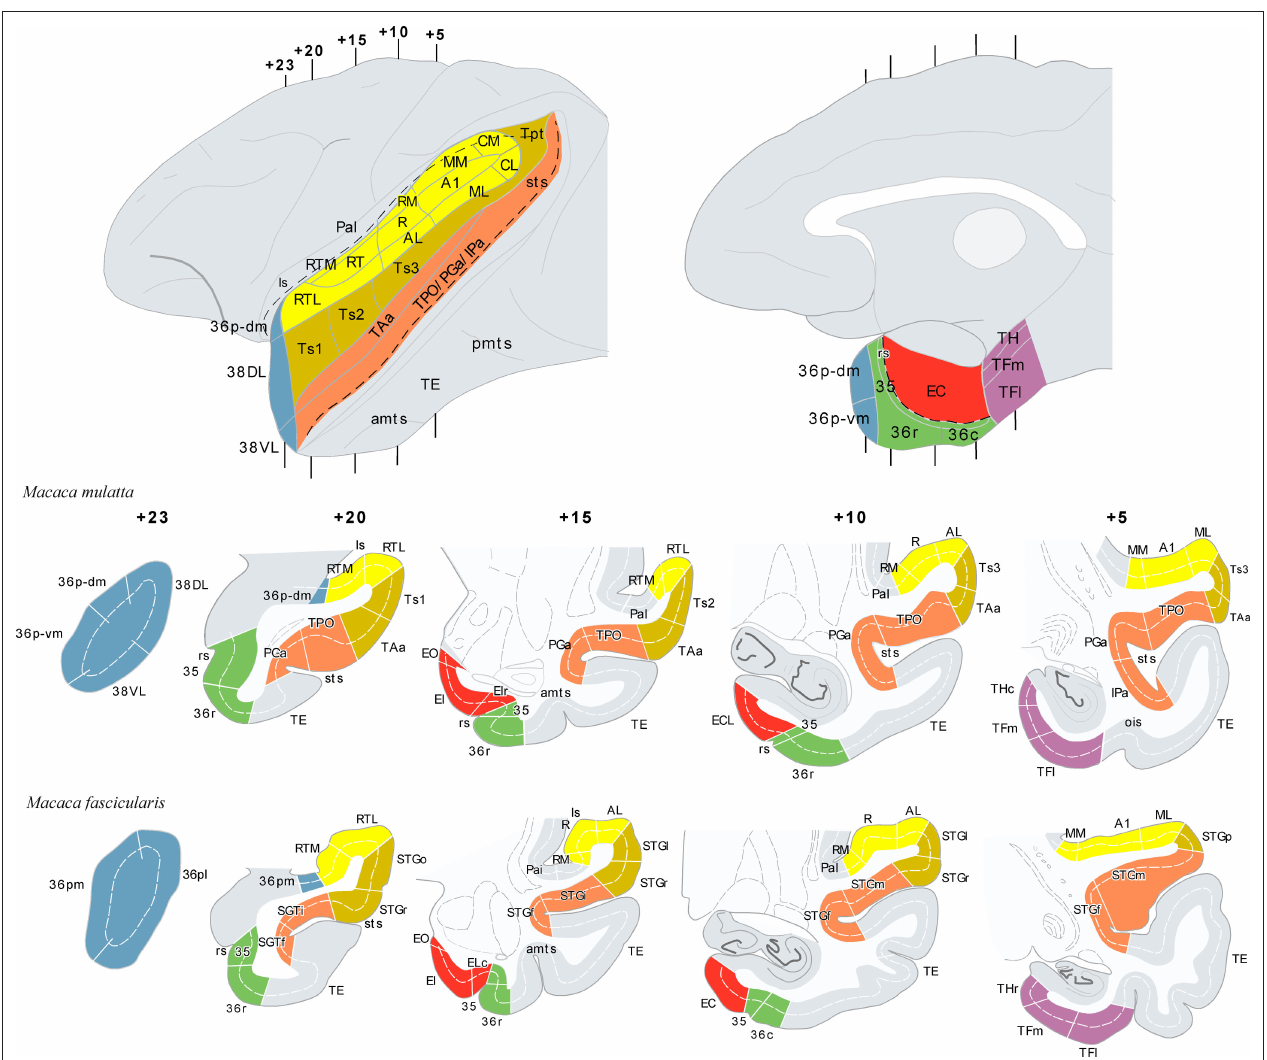
the rhesus monkey ( Macaca mulatta ) and of the cynomolgus monkey ( M. fasciculari s). Numerals precede by + refer to approximate coronal levels anterior to the interaural plane. See list of